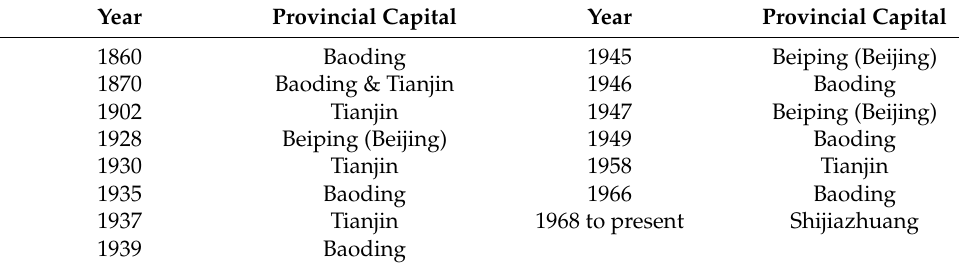
Table 4. Migration of the capital of Hebei Province since late Qing